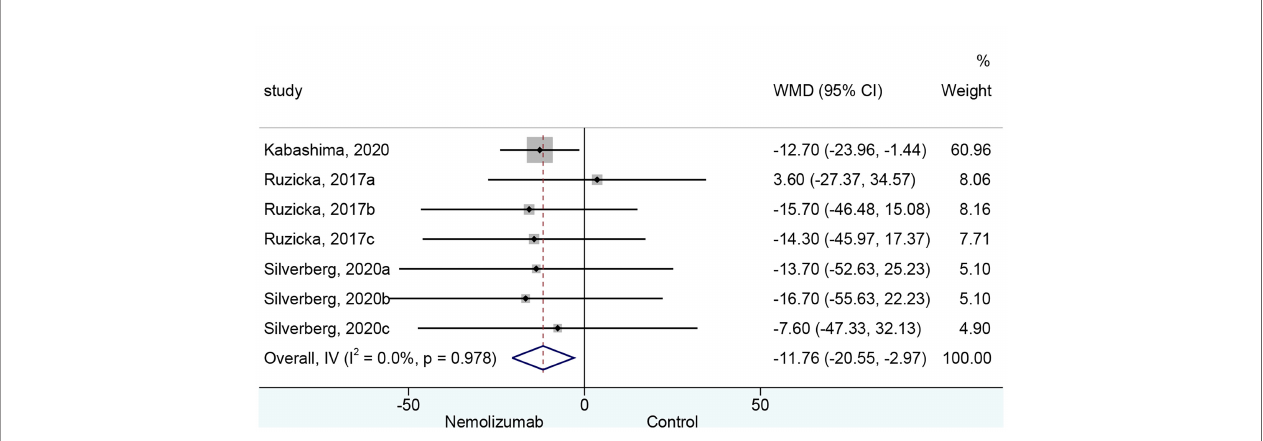
FIGURE 3 | Forest plot of Eczema Area and Severity Index comparing nemolizumab